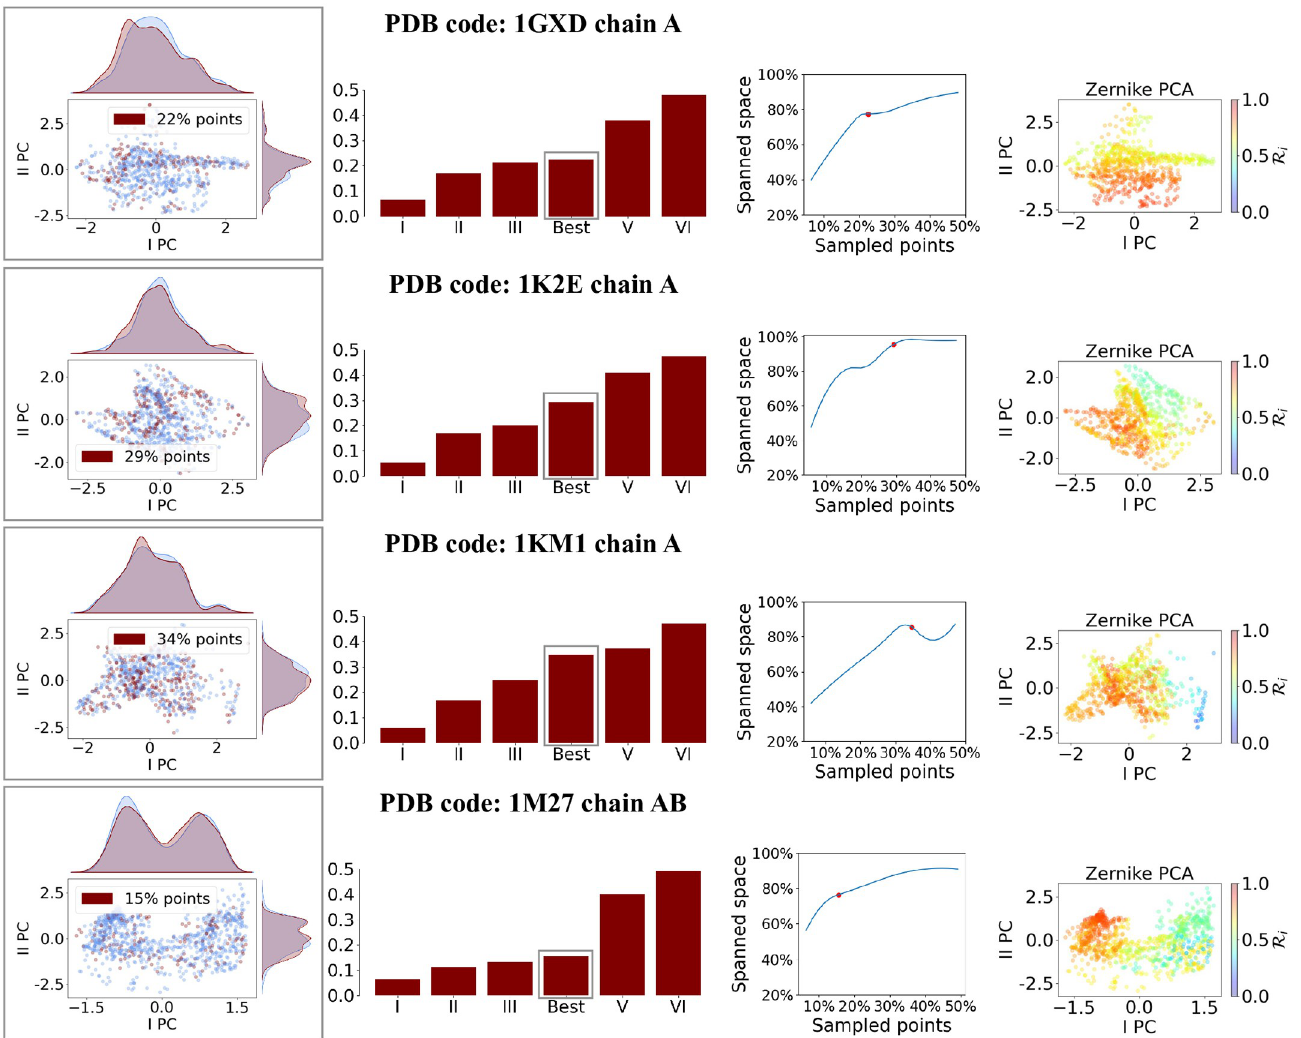
Fig 7. Principal component analysis of the total and sampled points Zernike vectors for four binding regions. For each of the four considered proteins, the PCA of the Zernike vectors describing the interacting region is performed. The first column shows the projection on the first two PCs of the Zernike vectors of each point in the patch (in blue) and of the points selected with the optimal sampling (in red), with the respective marginal density distributions. The percentage of sampled over total points is reported in the legend. The bar plots in the second column show the percentage of points sampled with different sets of parameters; the bar in the box corresponds to the optimal set. In the third column the percentage of spanned PCs space as a function of the number of sampled points for different sets of parameters is shown. The last column reports the points in the PCs space colored according to the roughness of the centered patch.